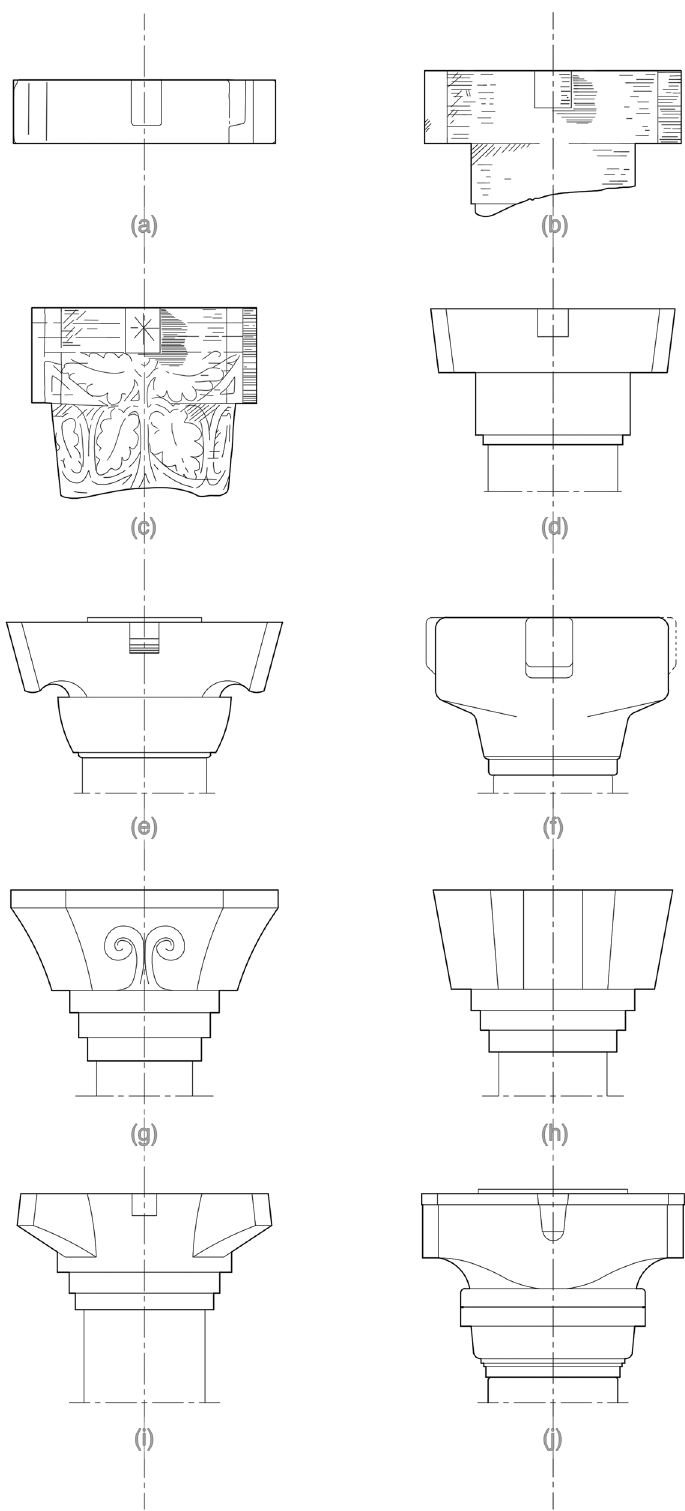
Figure 11: Selected blocked - out capitals: ( a ) Karnak; ( b and c ) Medinet Habu; ( d and e ) Kom Ombo; ( f ) Didymoi; ( g and h ) Karanis; ( i ) Coptos; ( j ) Kourion ( drawing: U. Kra ś niewska, S. Pop ł awski, based on the studies by Boak & Peterson, 1931, Figure 77; Brun et al., 2011, pp. 33 – 47; El - Masekh et al. 2017, p. 224; El - Nassery et al., 1976, pp. 239 – 271, Pl. LXVIII: 47; Grawehr & Brzozowska - Jawornicka, 2020, pp. 181 – 200, Figure 2; Hölscher, 1954, p. 190. 46 a,b; Laroche - Traunecker, 2000, p. 210 )